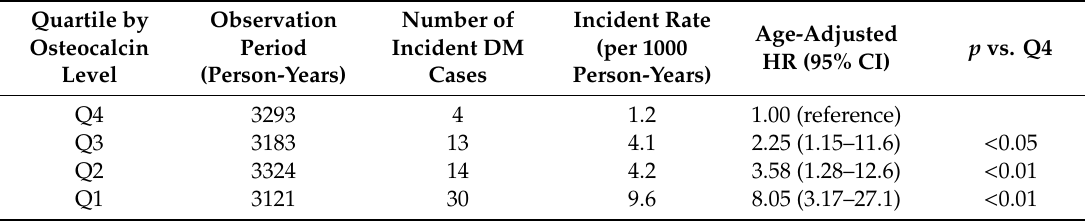
Table 3. Age-adjusted incidence rates of diabetes mellitus with reference to the quartile with baseline osteocalcin levels. (Adapted from [44]).